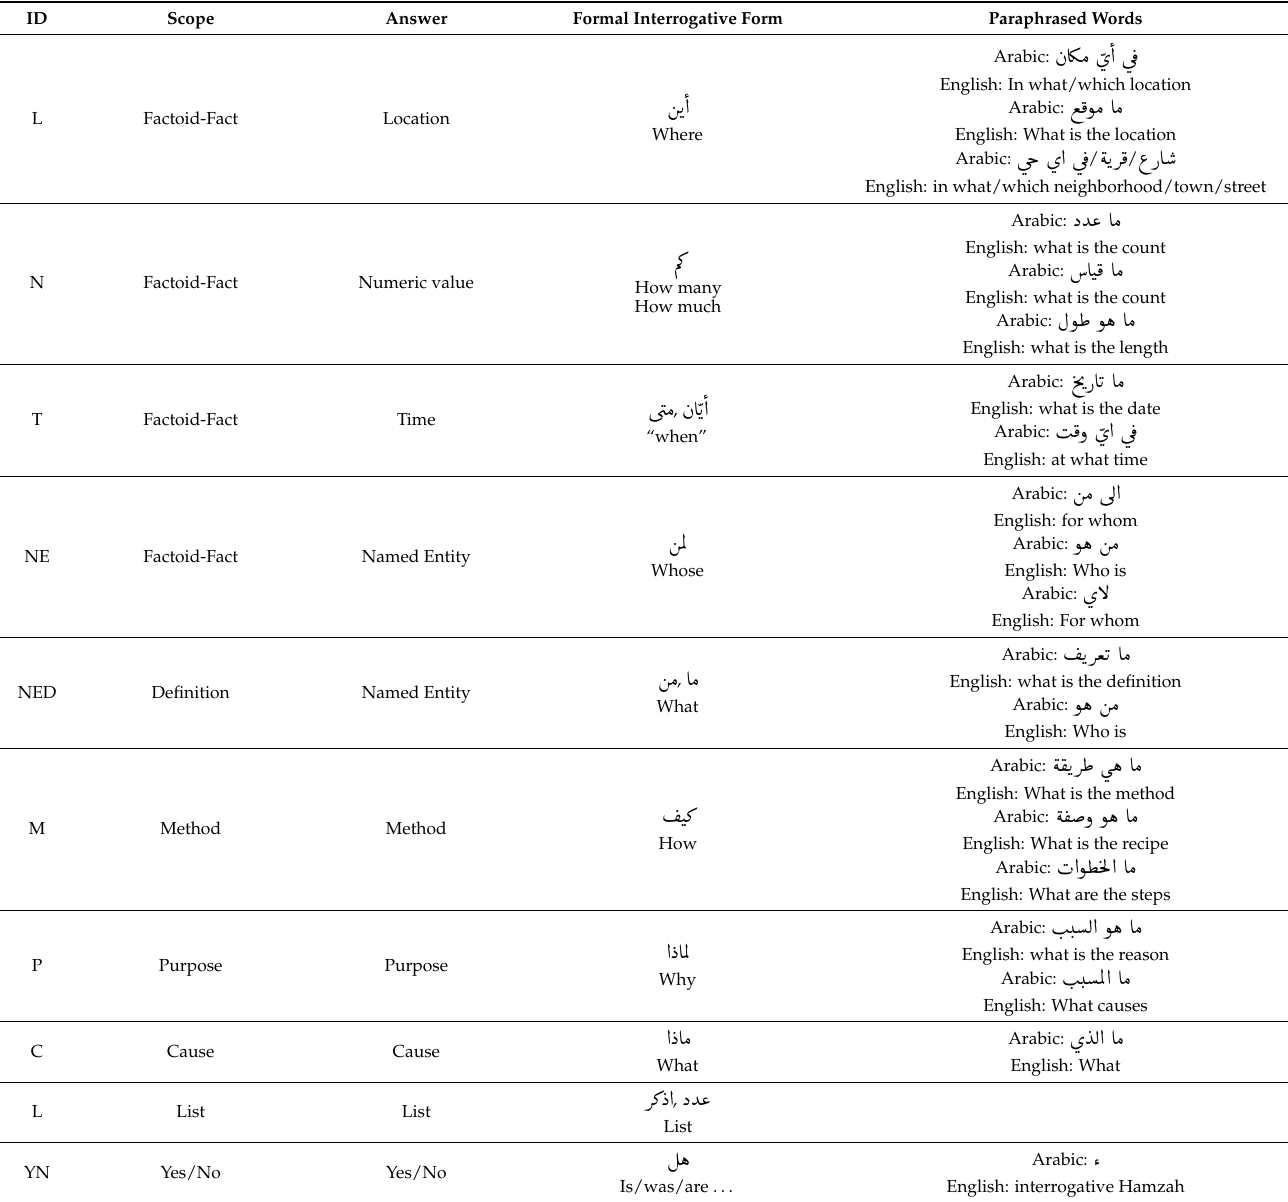
Table 1. Common scopes of Arabic